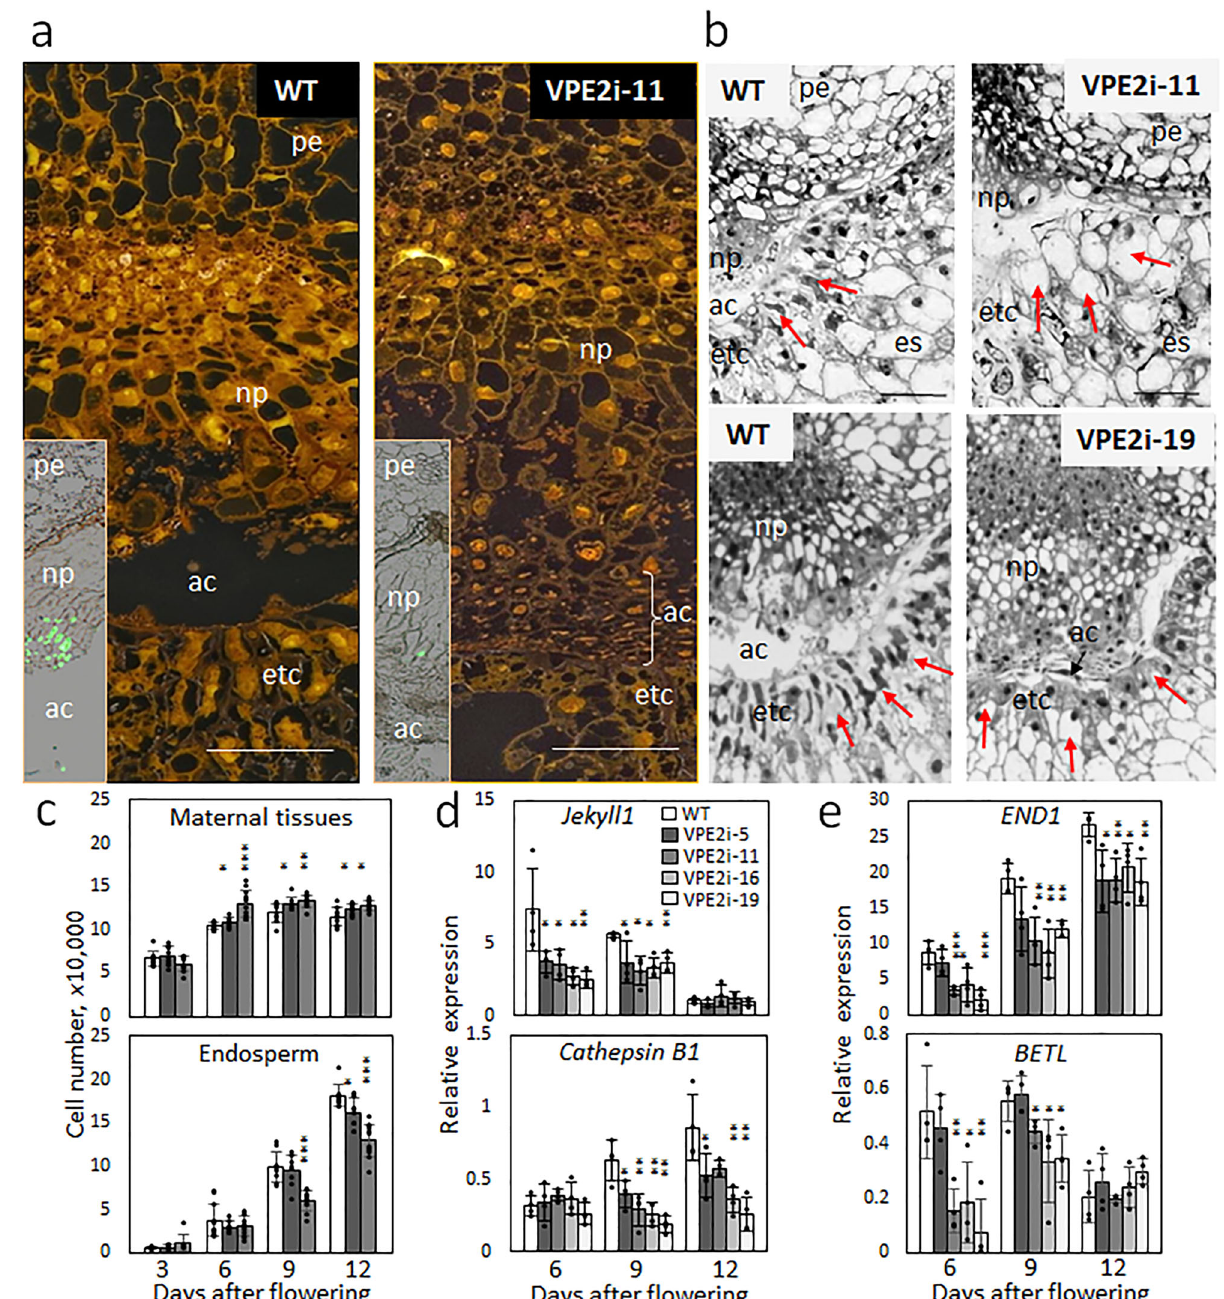
Fig. 4 The effect of suppressing VPE2 subfamily on development at the maternal – fi lial interface. a The characteristic of cell differentiation in NP of a WT (left panel) compared with VPE2i-11 grain (right panel) at 9 DAF. Non-disintegrating cells fi lled the apoplastic cavity of the transgenic grain. Inlets visualize nuclei degradation (TUNEL assay) in NP of WT and VPE2i-11 grains (see also Supplementary Fig. 4.) b The morphology of the ETCs, formed in a WT grain (left panel), is characterized by densely packed cells (arrowed), whereas the ETCs formed in a transgenic grain (right panel) are highly vacuolated. c Cell numbers in the maternal tissue and the endosperm in developing grains of WT and RNAi-VPE2 transgenic lines. d and e Transcript abundances of PCD-related genes Jekyll1 and cathepsin B1 ( d ) as well as END1 and BETL , both encoding proteins involved in the ETC differentiation ( e ), in the developing grains of WT and transgenic lines. Data shown as the mean ± SD ( n = 10 in c , = 4 in d and e ). *, **, ***: means differ at, respectively, P < 0.05, < 0.01, and < 0.001. Bars = 50 mm in a and b . Abbreviations: ac apoplastic cavity, DAF days after fl owering, es endosperm, etc endosperm transfer cells, np nucellar projection, pe pericarp, WT wild micro-spectroscopy 23 , revealed that the transgenic grains ’ peri- subunit S1a ( AGP-S1a ) and granule-bound starch synthase 1a ( GBSS1a ), all of them are active exclusively in the endosperm 22 , carp accumulated more sucrose and starch than did the equiva- was lower in the transgenic grains than in the WT, whereas the lent tissue in the WT grains (Fig. 6d, e). The overall conclusion opposite was the case for a pericarp-speci fi c 22 GBSS1b (Fig. 6c). was that the compromised allocation of sucrose resulting from An analysis of grain sections, based on Fourier-transform infrared knocking down VPE2 subfamily resulted in an altered pro fi le of